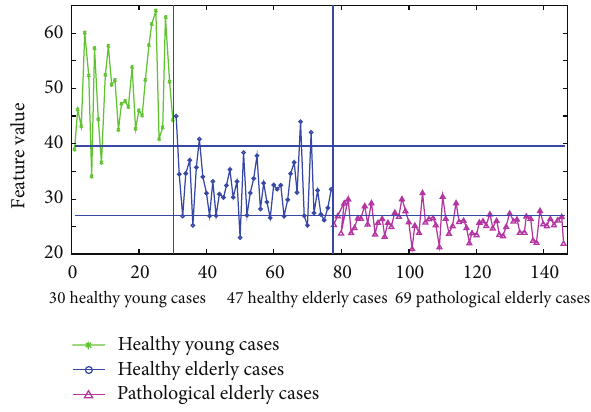
Figure 17: Differentiation between healthy young, healthy elderly, and pathological elderly cases (suffering from CAD), when using the normalized sum of the areas under the corresponding FT 2 curve for each case, as a classification feature or